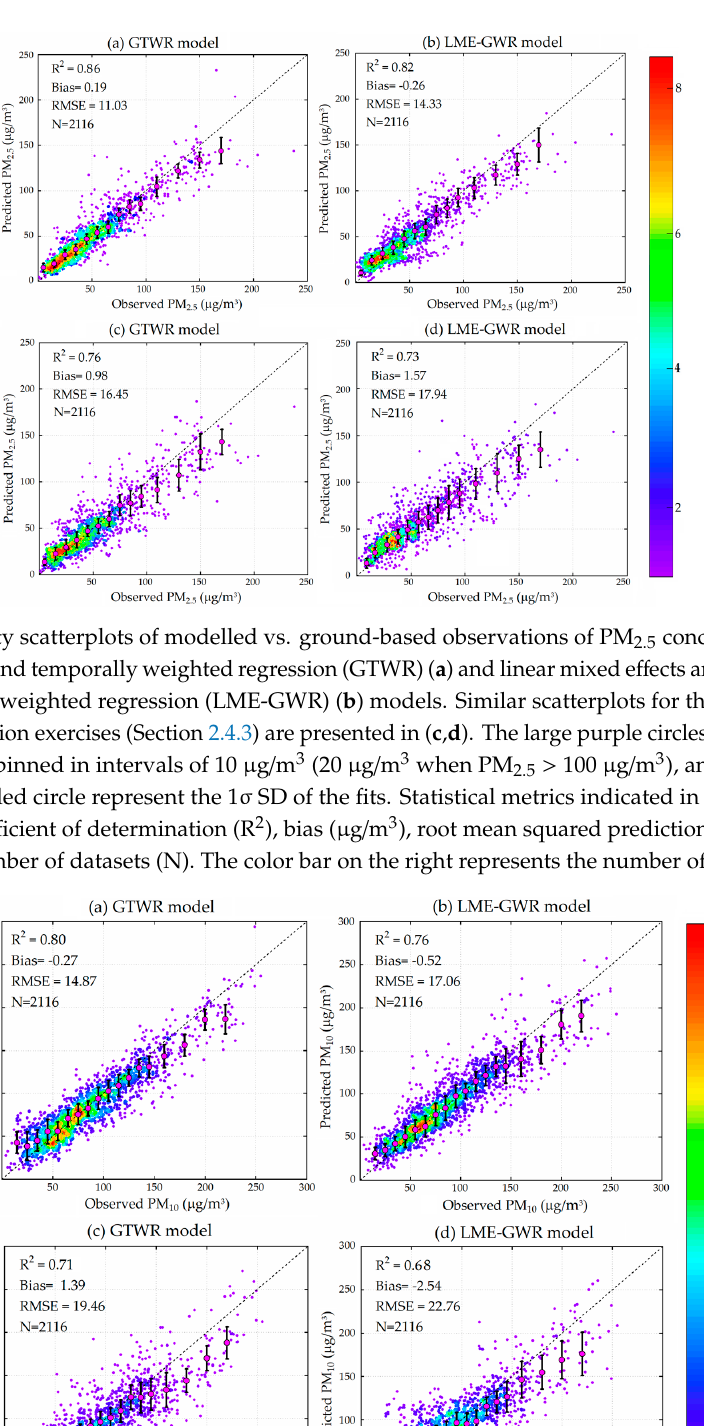
Figure 8. Density scatterplots of modelled vs. ground-based observations of PM 10 concentrations for